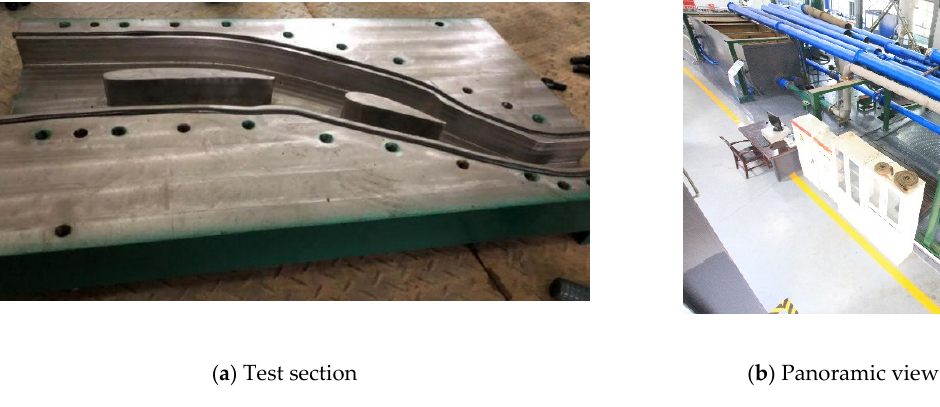
Figure 6. ( a , b ) Physical drawing of the test bench.